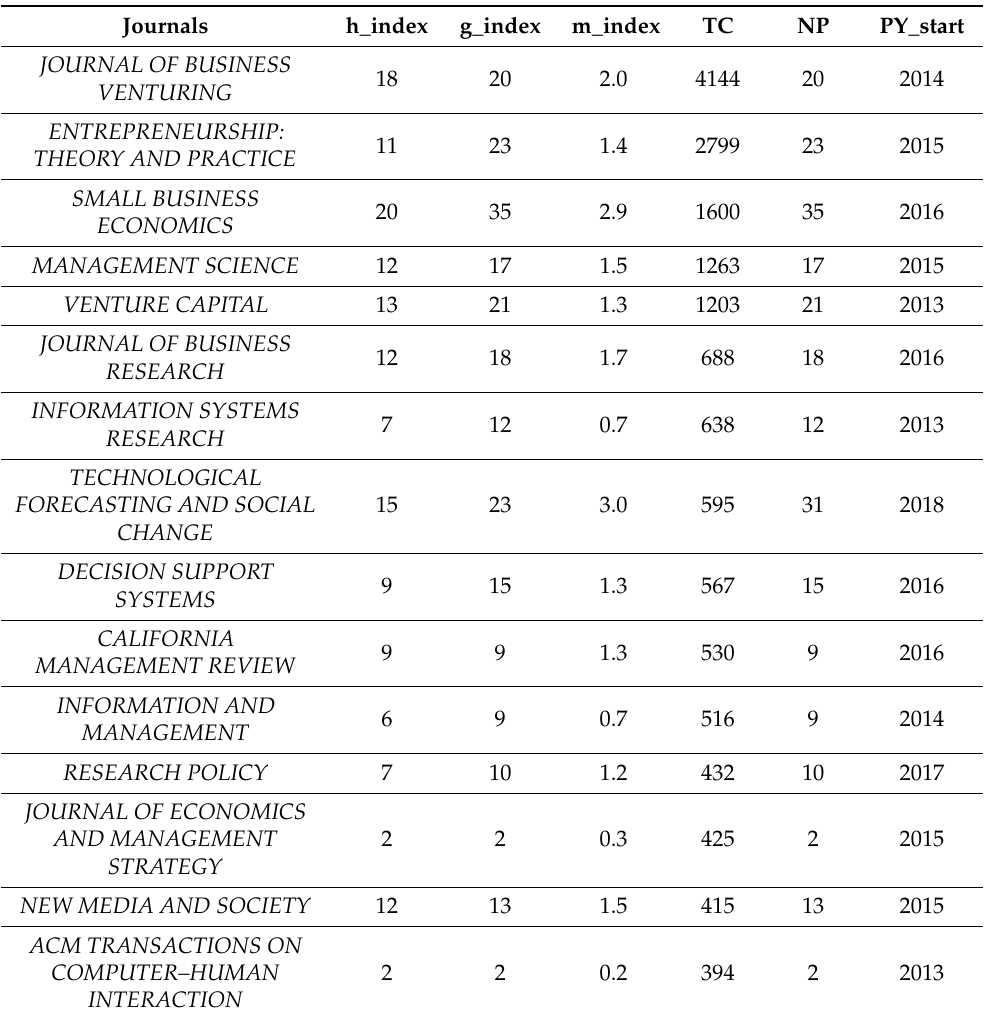
Table 5. The most influential sources.